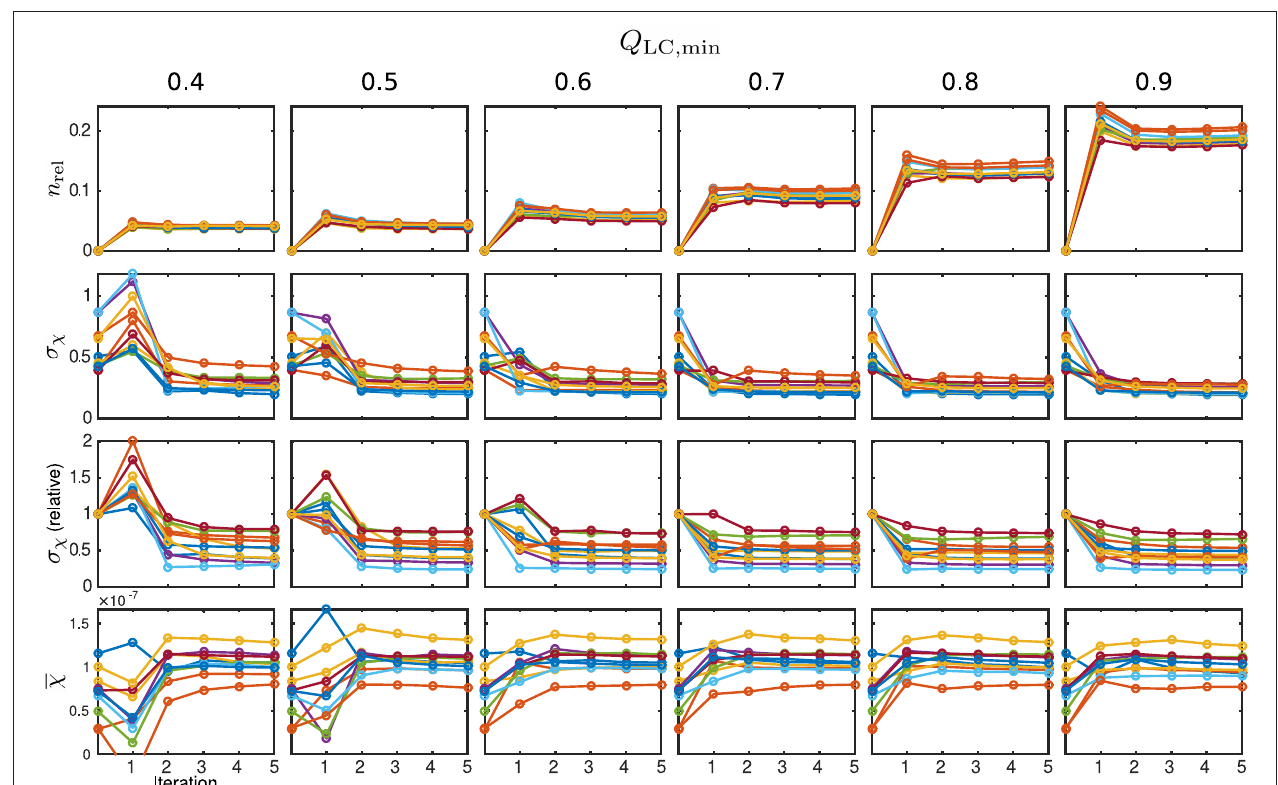
FIGURE 11 | Susceptibility and mask results from in vivo measurements. One individual colour is used for each subject. From the top row to bottom: relative mask difference, n rel , between a mask from the classic approach and the REFRASE result; heterogeneity (standard deviation, σ χ ) of susceptibility within reference area; heterogeneity relative to conventional result without REFRASE; mean susceptibility value ( χ ) inside reference area. Each graph shows the conventional calculation without REFRASE as 0th point and the iteration result of